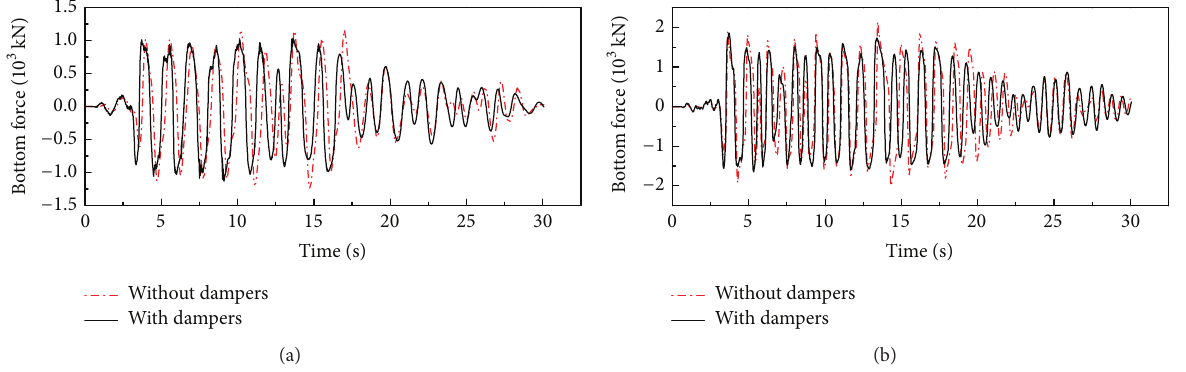
Figure 10: Time histories of the bottom shear: (a) longitudinal direction; (b) transverse